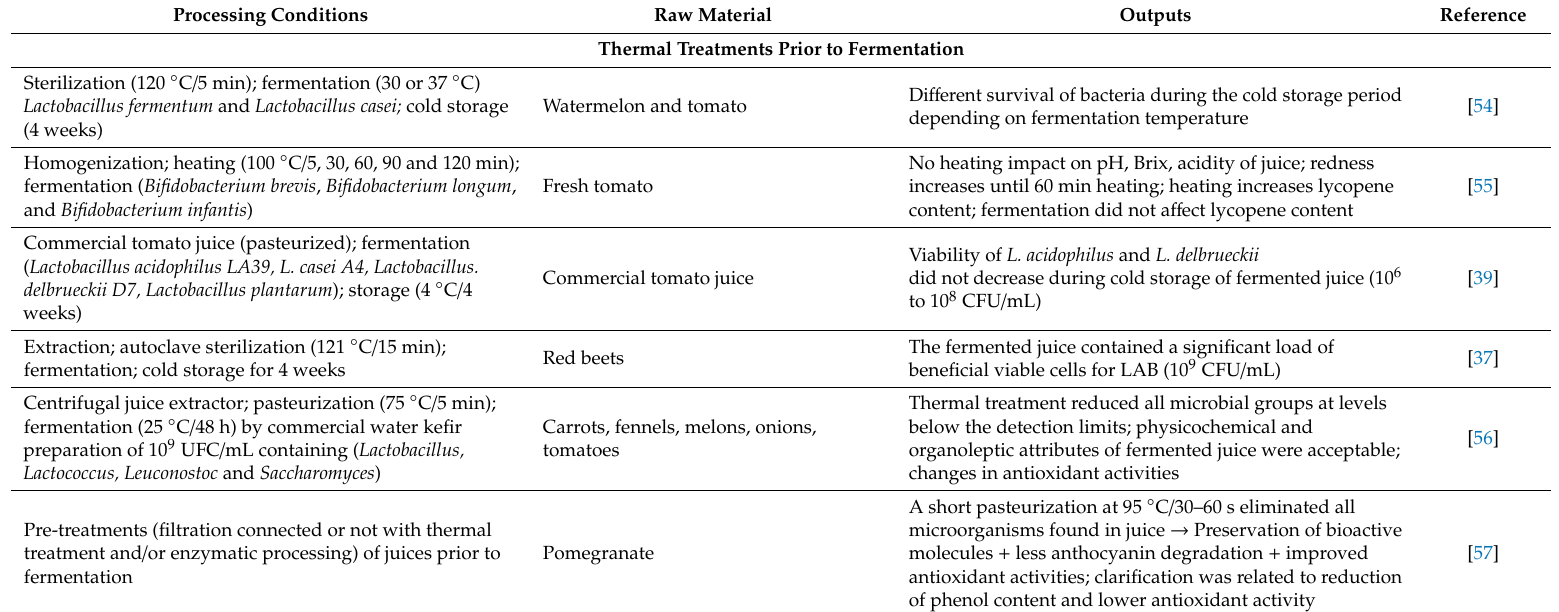
Table 1. Process parameters for lactic fermentation of fruit and vegetable